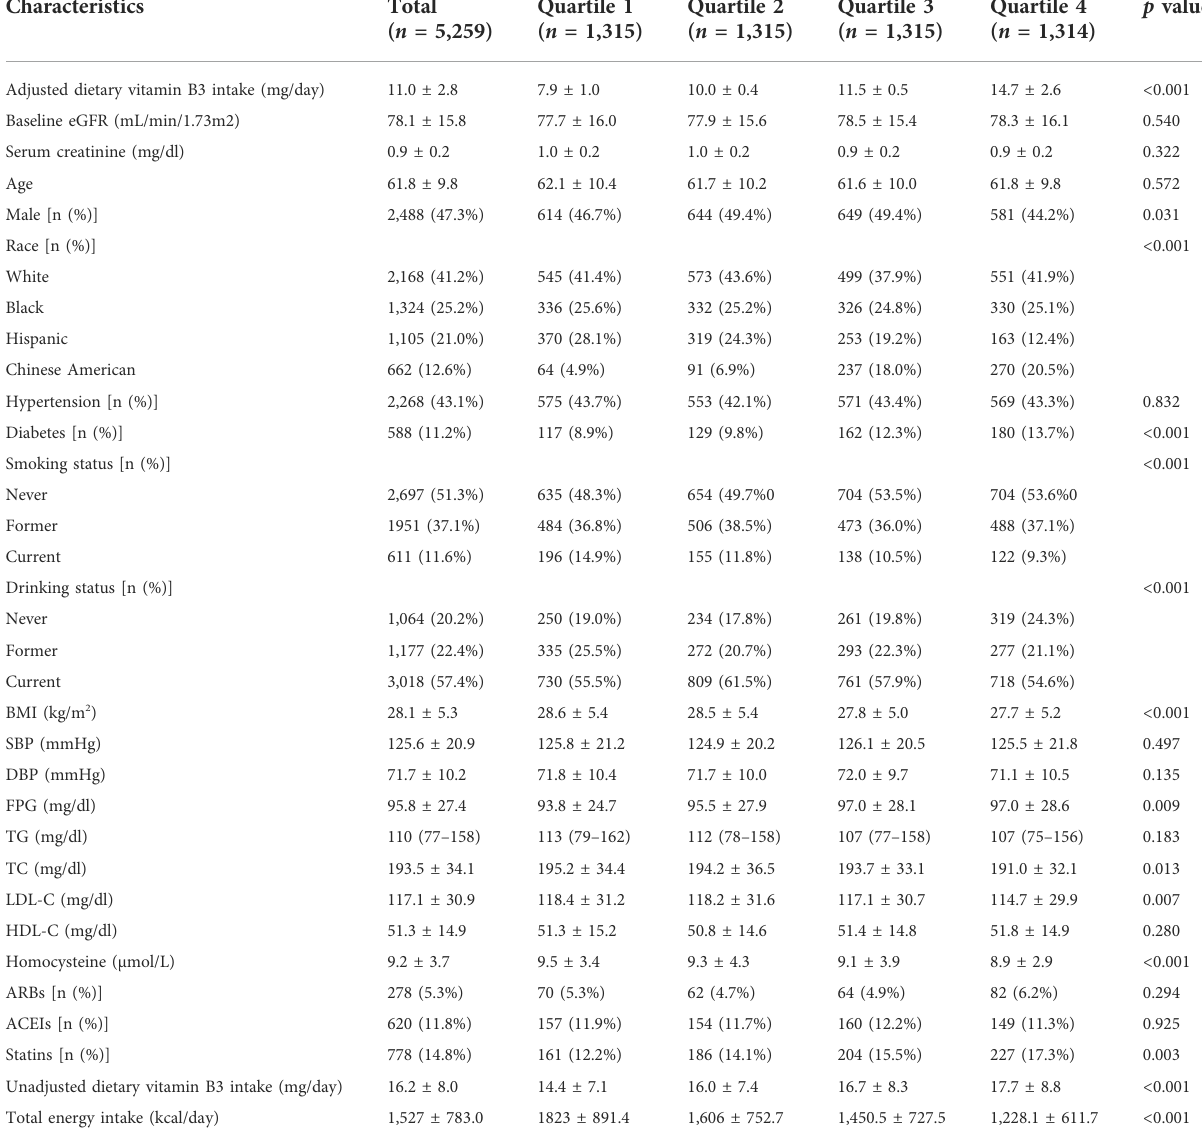
TABLE 1 Baseline characteristics by the quartiles of energy-adjusted dietary vitamin B3 intake.